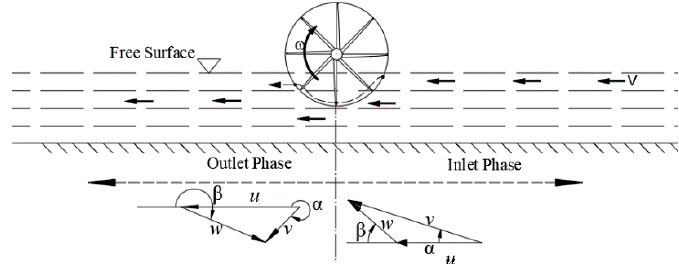
Figure 10. Diagram of velocity triangles.